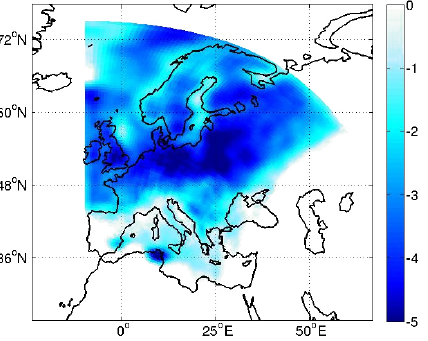
Figure 14. Difference in the annual mean aerosol number concen- trations for the (PD–PI) simulation expressed as a